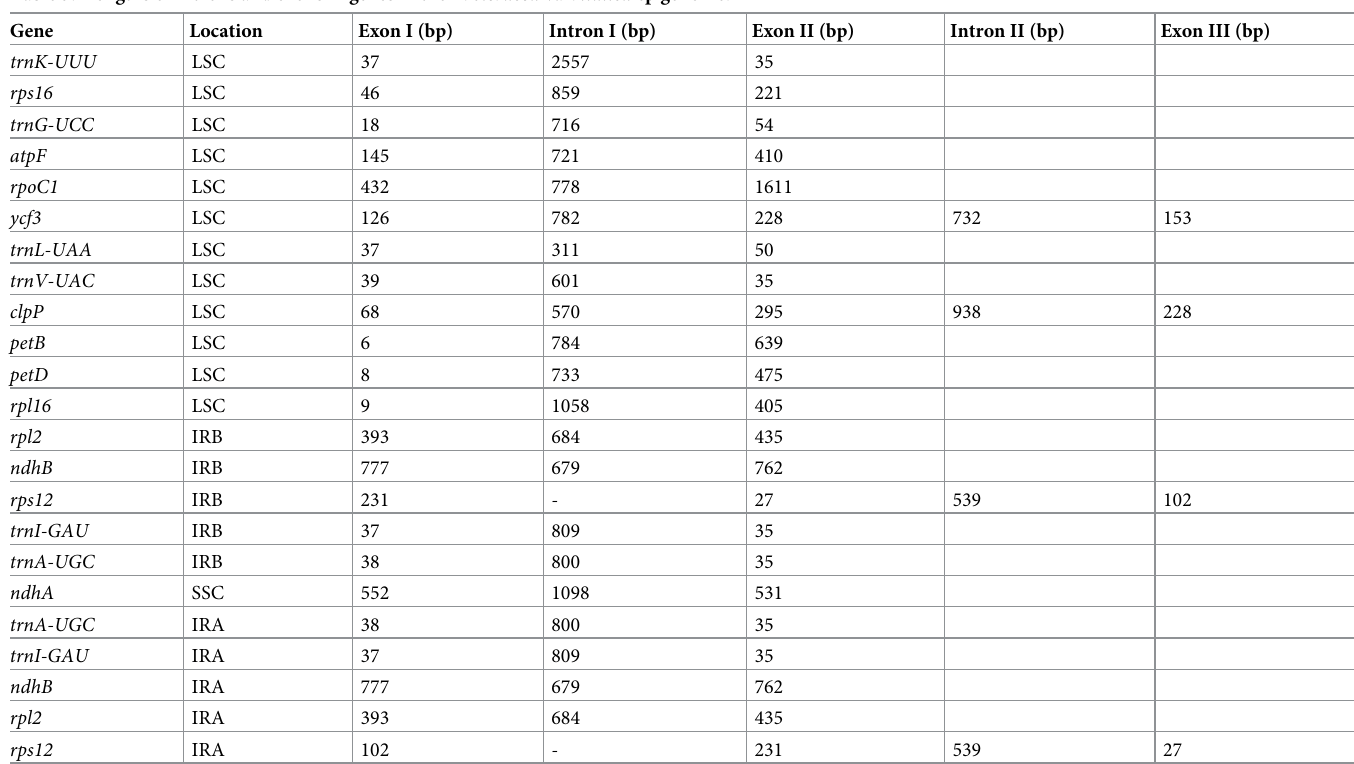
Table 3. Lengths of introns and exons in genes in the B . oleracea var. italica cp genome. Gene Location